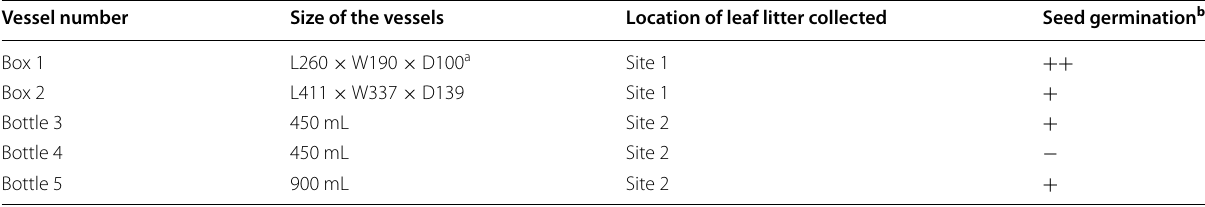
a Length (L) width (W) depth (D) (mm) × × b , a large number of protocorms and seedlings were observed; ++